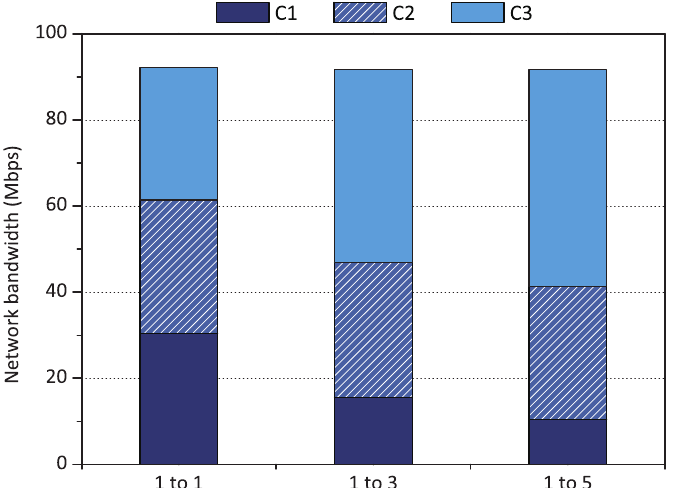
Figure 7. Proportional share scheduling evaluation results of qCon when the weight sets were 1 to 1 , 1 to 3 , and 1 to 5 .